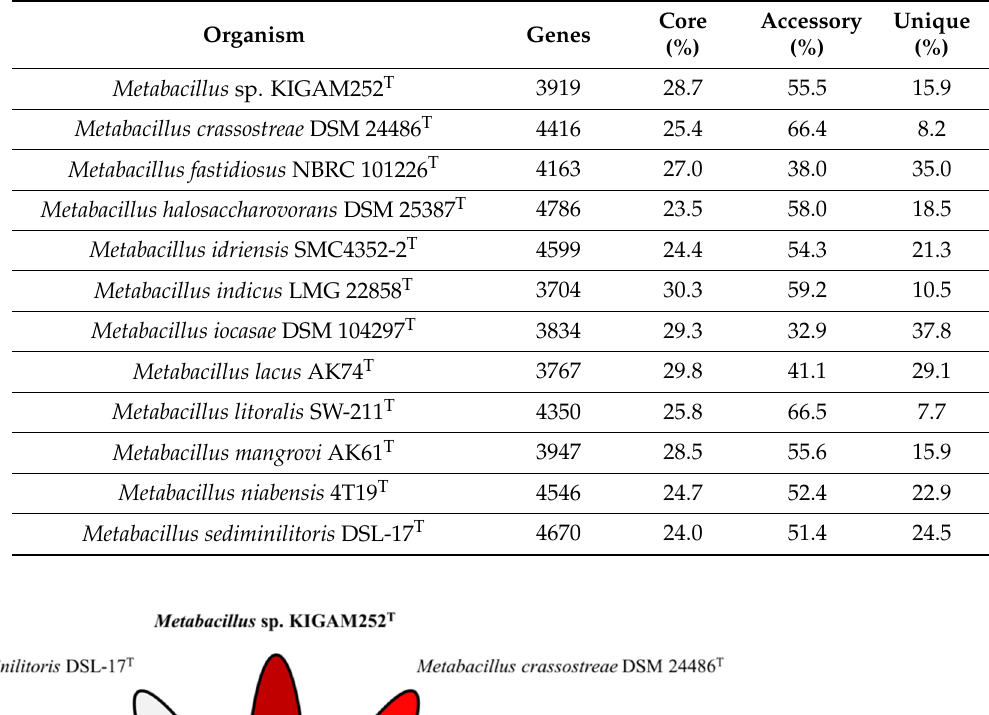
Table 4. The fraction of core, accessory, and unique genes of strain KIGAM252 T and related Metabacil- lus species.